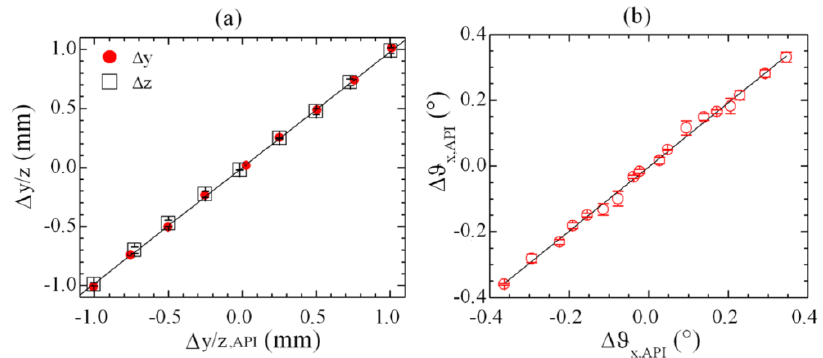
Figure 10. (a) Transverse target displacement  y (red marks) /  z (black marks) and (b) roll  , measured at a distance of 120 cm from the laser source, as a function of the x reference displacement, whose nominal resolutions are 0.1  m for transverse displacement and 3  10 -5 ° for roll rotations. The vertical error bars are nearly always within the symbol size. The best linear fit, represented by the continuous lines, have equations + 0.00155 (R 2 = 0.9997) and  = 0.9768  - 0.00287  y/z = 1.02197  y/z API x x,API (R 2 =